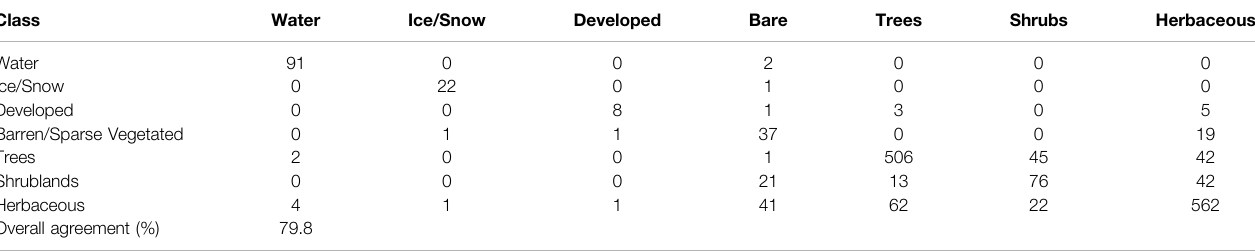
TABLE5| ConfusionmatrixcomparingtheV1.0GLanCElandcover(inrows)withtheESAWorldCoverdataset(incolumns)forNorthAmericanreferencedatapresentedin Table 3 . Note that the number of sites in each GLanCE class varies slightly with those in Table 4 because 16 sites (1%) had different labels in 2019 than in 2010.